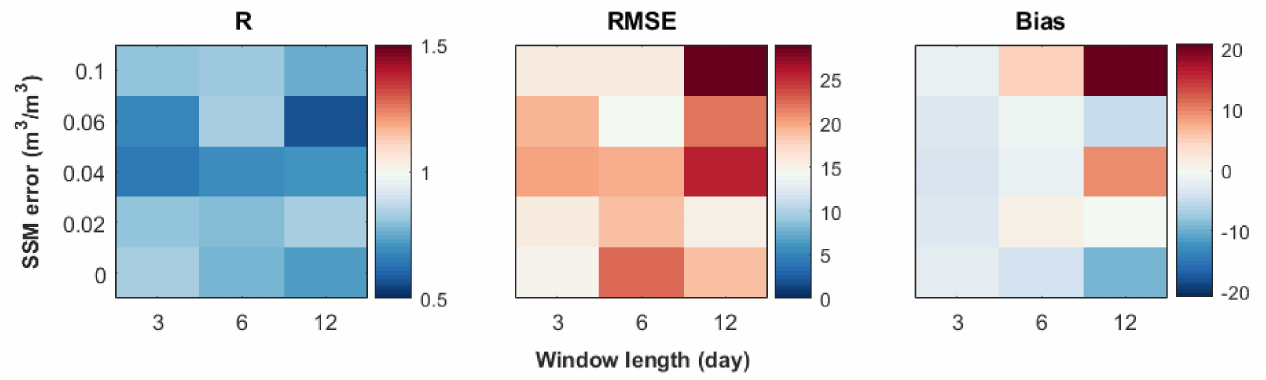
Figure A1. Statistical metrics of the synthetic experiment for the 15-days accumulative amounts using drip irrigation technique at different window length: 3 6 and 12 days and for different errors on the surface soil moisture (SSM error).